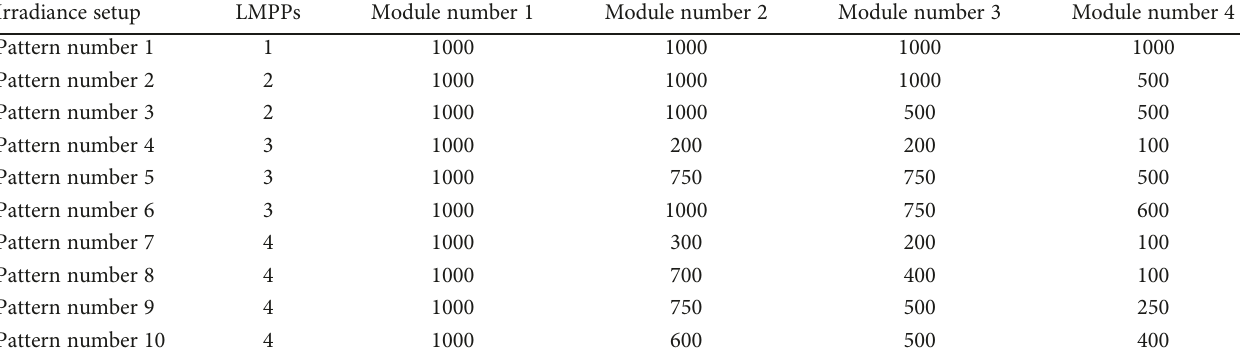
Table 2: Irradiance setups of the 10 evaluation patterns (W/m 2 ).